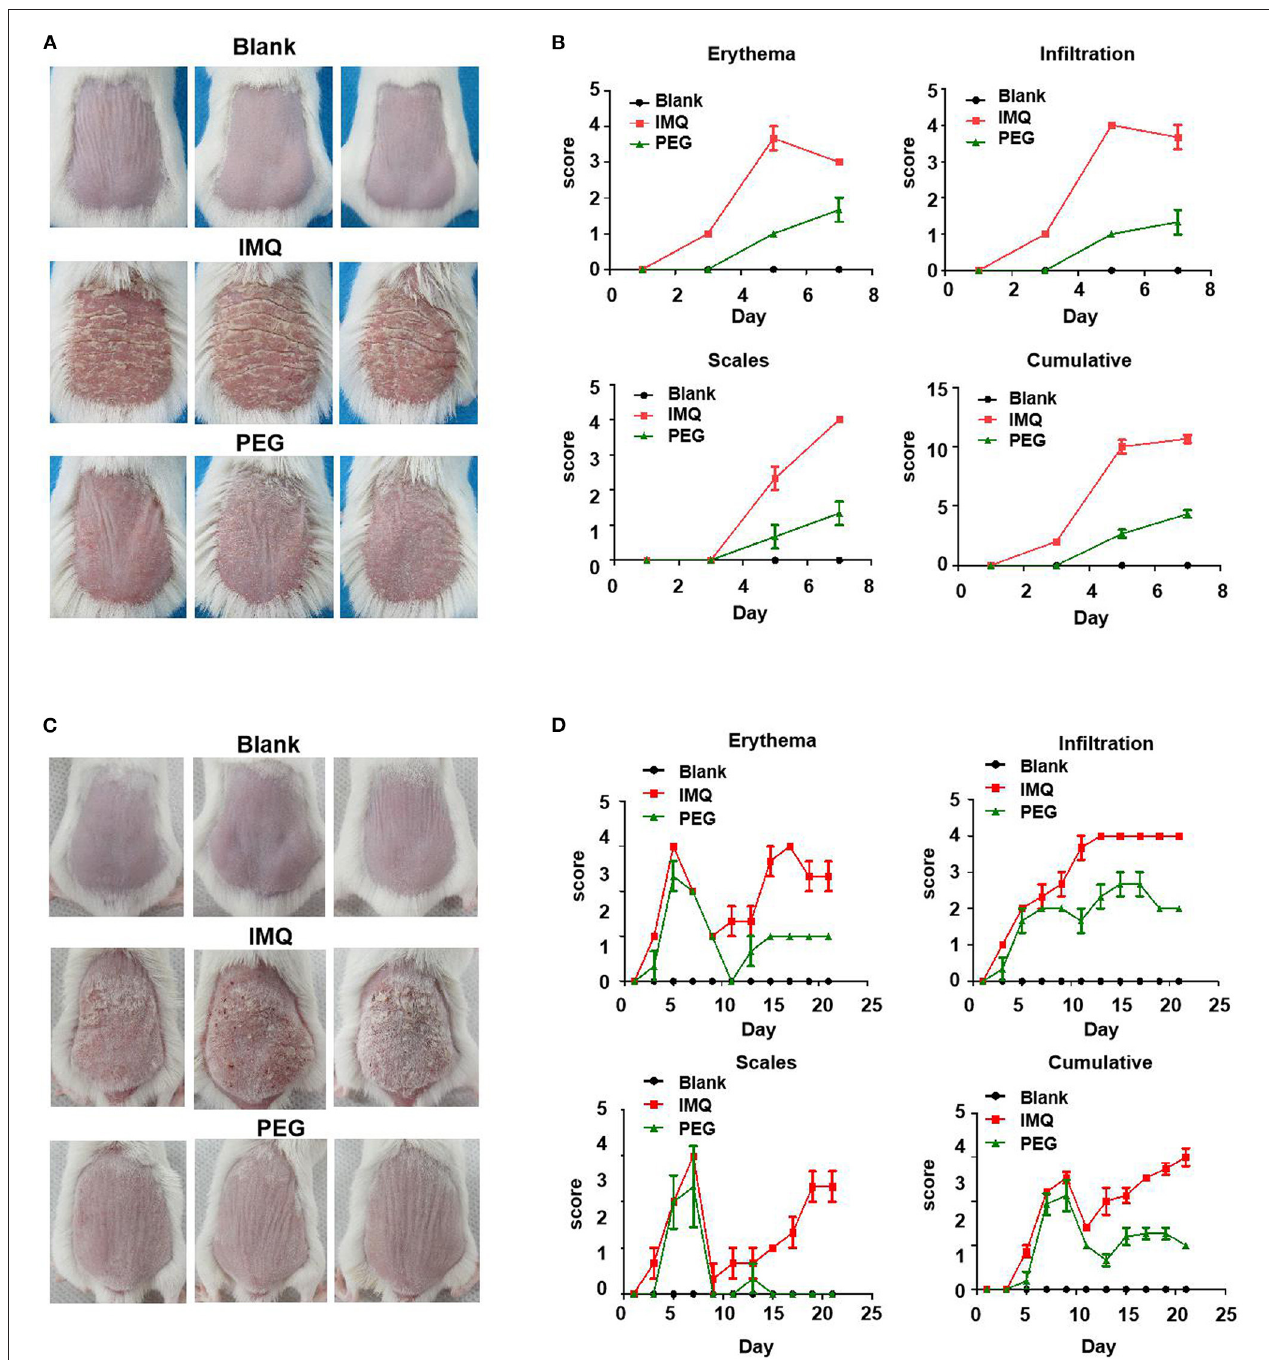
FIGURE 1 | Skin lesion appearance of the IMQ-induced psoriasis mouse model, PASI score graph. (A) At the end point of the psoriasis mouse model for 7 days, before all mice were killed, photos had been taken, with six mice in each group, and three images were selected for each group. (B) Scores of erythema, scales, and infiltration of skin lesions in each group at different time points. (C) At the end point of the psoriasis mouse model for 21 days, before all mice were killed, photos had been taken, with six mice in each group. (D) Scores of erythema, scales, and inltration of skin lesions in each group at different time points. We have repeated the experiment more than three